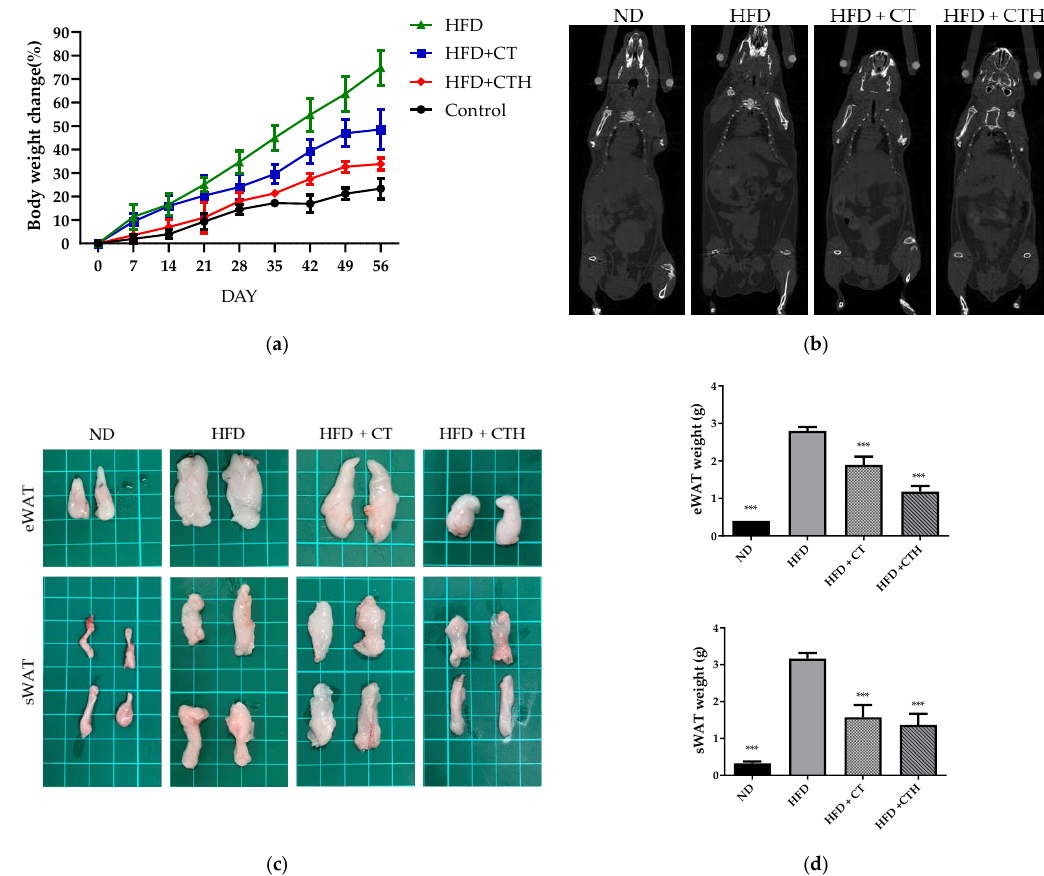
Figure 4. Evaluation of the bodyweight and fat accumulation ( a ) Eight-week weight record for normal diet group (ND), high-fat diet group (HFD), high-fat diet with CT group (HFD + CT), and high-fat diet with CT combined hesperidin (HFD + CTH). Two-way ANOVA with multiple comparisons ( n = 6, *** p < 0.001 for HFD + CT vs. HFD). ( b ) CT images of mice with a resolution voxel spacing of 35 μm. ( c ) Representative images of epididymal white adipose tissue (eWAT) and subcutaneous white adipose tissue (sWAT). ( d ) Weight of eWAT and sWAT. One-way ANOVA with multiple comparisons compared with HFD ( n = 6 for each group, *** p < 0.001).